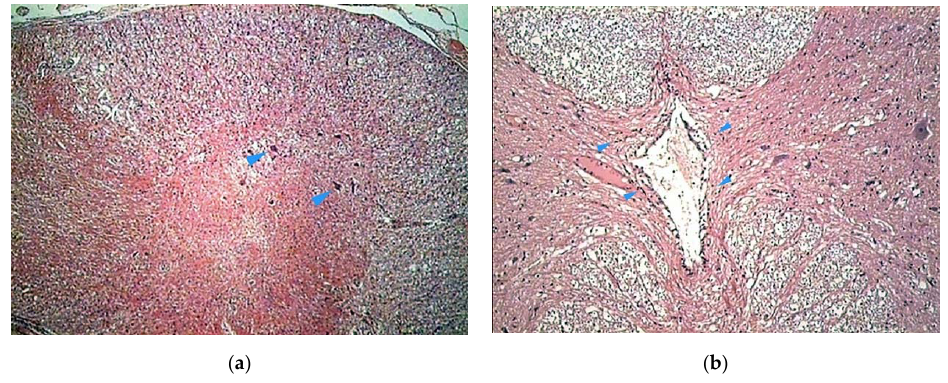
Figure 2. Histologic study executed on a dog’s bone specimen. Hematoxylin–eosin 2.5X ( a ) and 10X ( b ), showing the presence of live osteocytes and osteoblasts near the osteotomized surface